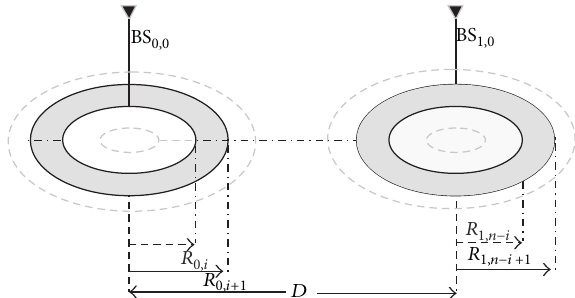
whether the 𝑖 th layer of BS 0,0 borrows channels or not, and whether the (𝑛+1−𝑖) th layer of BS 1,0 lends channels or not will determine the channel allocation results. Next, the analysis of these four different cases are as